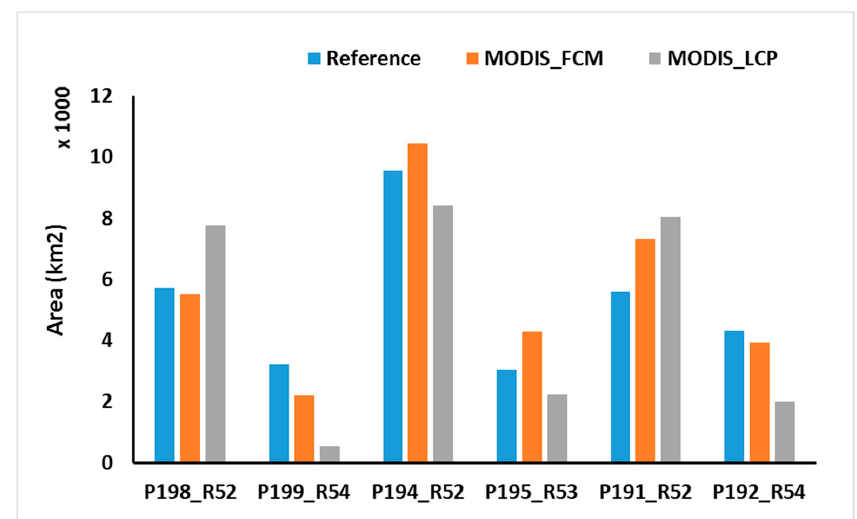
Figure 10. Comparison of cropland percentage in the six Landsat reference tiles derived from: (1) aggregated Landsat_CLM30 results (reference); (2) MODIS_FCM; and (3) MODIS_LCP. Note that a constant value of 0.5 was used to assess the cropland area from class 14 (cropland/vegetation mosaic) in the MODIS_LCP product.